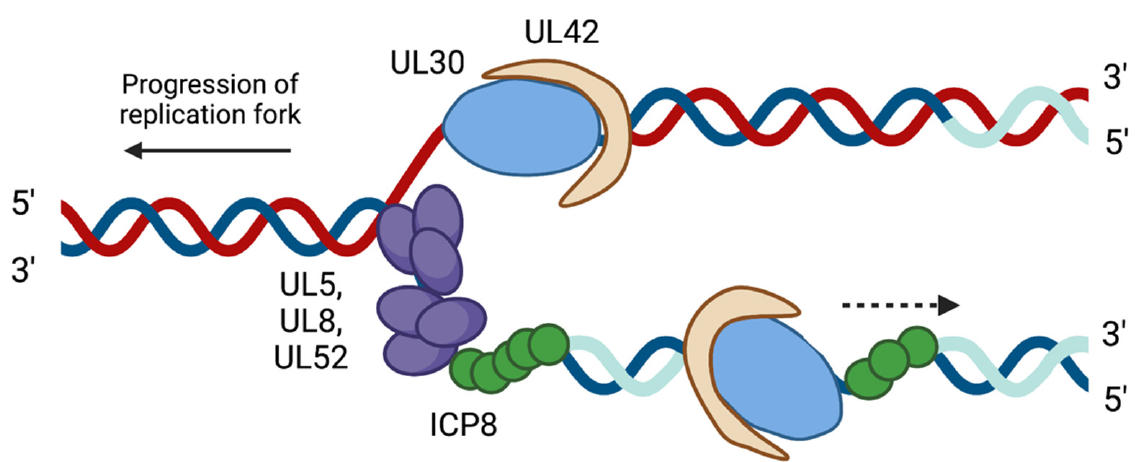
Figure 2. Diagram of the viral factors associated at a viral replication fork during HSV-1 DNA replication. Following the binding of the origin binding protein UL9 (not shown), DNA is unwound and RNA primers are synthesized by the helicase–primase complex (UL5, UL8, and UL52), shown in purple. The single-stranded DNA binding protein ICP8 coats single-stranded DNA (green). The viral polymerase UL30 (blue) and the processivity factor UL42 (beige) carry out leading (top) and lagging (bottom) strand synthesis. The RNA primers are shown in light blue. Created with BioRender.com, accessed on 28 September 2021. Adapted from Dembowski, Dremel, and DeLuca, PLoS Pathogens, 2017 [15].